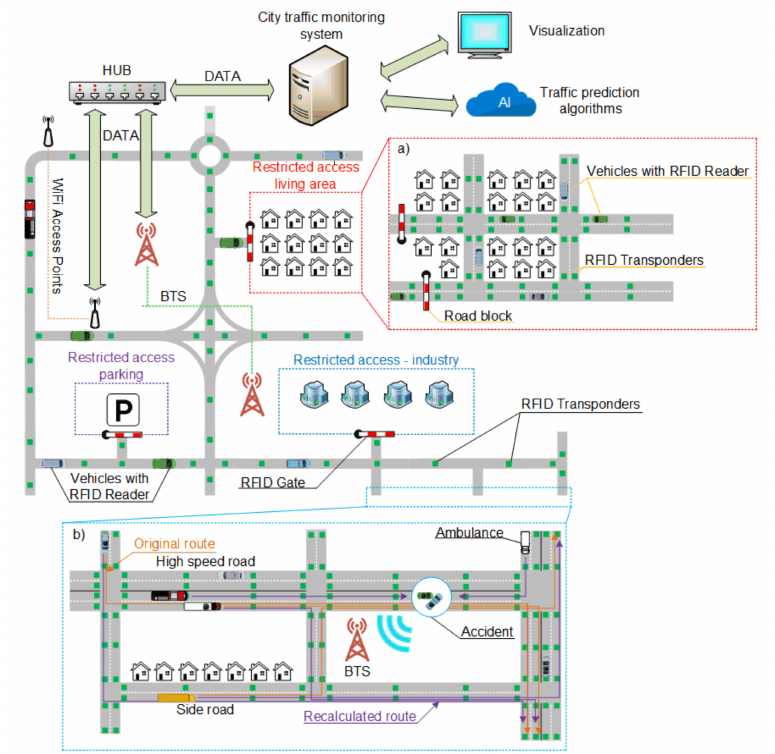
Figure 6. City tra ffi c infrastructure with RFID transponders placed in the road surface: ( a ) RFID vehicle tracking, ( b ) the detection of an accident and route